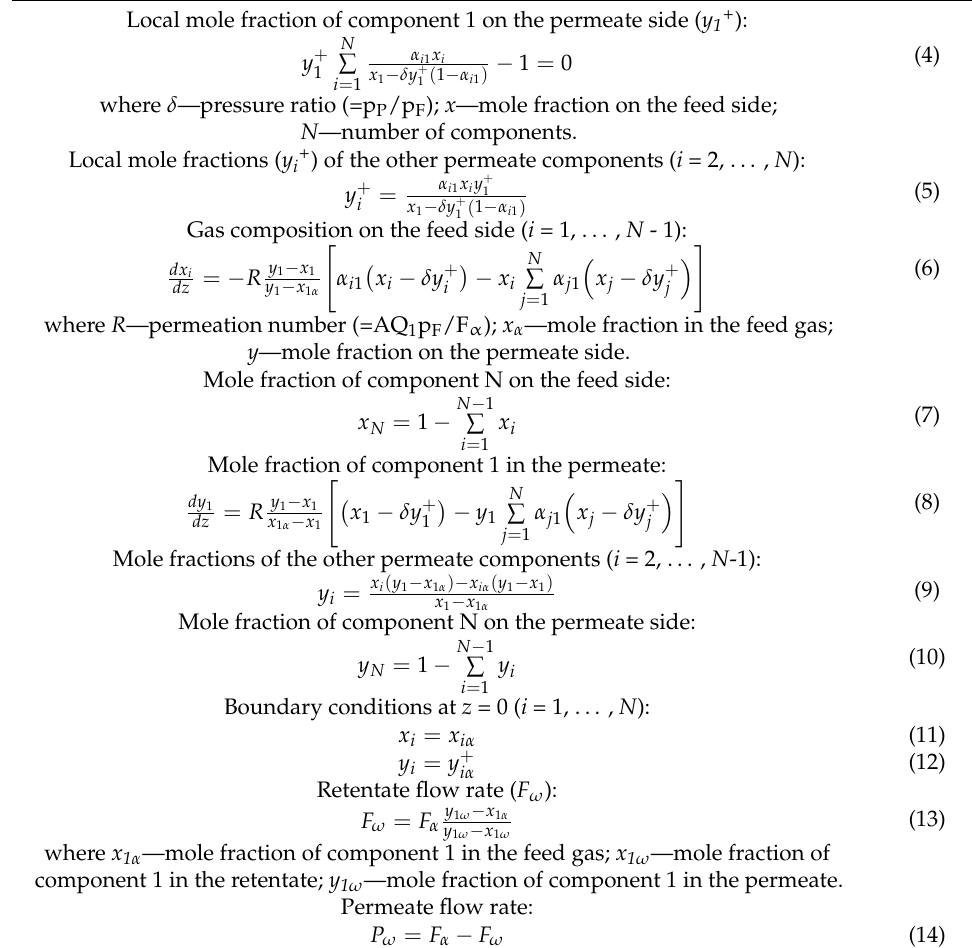
Figure 2. Gaseous streams in a membrane module for plug flow on the feed side and unhindered flow on the permeate side. Table 1. Mathematical model equations and boundary